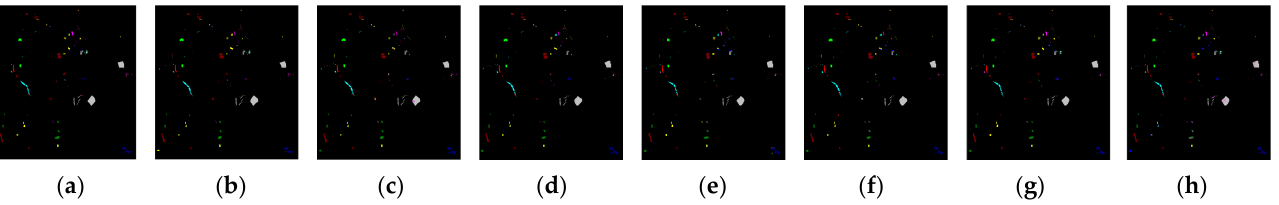
Figure 29. Classification maps using different methods on the Chikusei dataset: ( a ) SCL – MSR; ( b ) SCL; ( c ) FDSCC; ( d ) DBDA; ( e ) DBMA; ( f ) SSRN; ( g ) SiamSCL; ( h ) EMP – SVM.